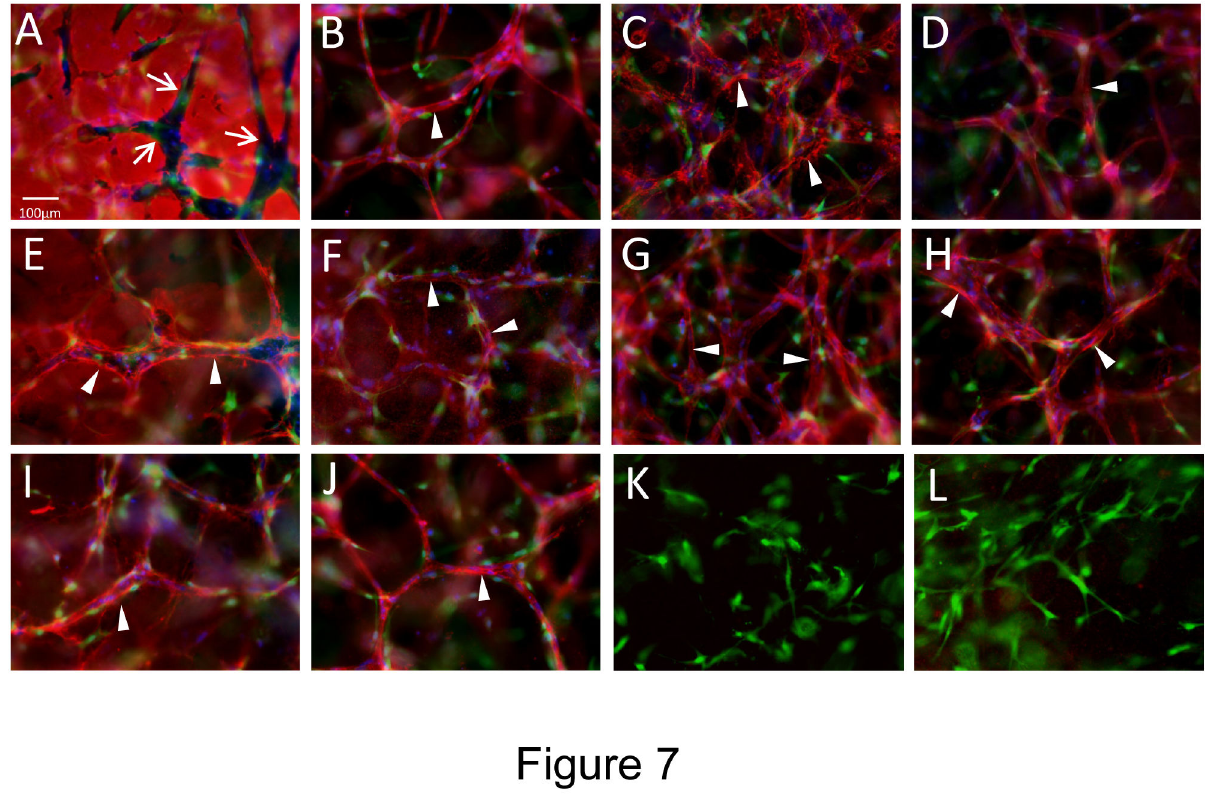
Figure 7. Hematopoietic stem cell cytokines stimulate EC-pericyte tube co-assembly and vascular basement membrane matrix deposition under serum-free defined conditions in 3D fibrin matrices. ECs were primed with VEGF/FGF-2 overnight and then were seeded with GFP-pericytes into 3D fibrin matrices containing SCF, IL-3, SDF-1α, Flt-3L, and FGF-2. After 120 hr, cultures were fixed and stained for extracellular antigens using various antibodies directed to: (A) Fibrin; (B) CD31; (C) Collagen type IV; (D) Laminin; (E) Fibronectin; (F) Perlecan; (G) Nidogen-1; (H) Nidogen-2; (K) Collagen type I; and (L) Collagen type III. In some cultures, the fibrin gel was supplemented with bovine fibronectin (I, J) and a monoclonal antibody that is specific for human fibronectin was used to assess fibronectin deposition within the vascular basement membrane (I). In this case, CD31 antibody staining was shown for comparison (J). In all other cases, the fibrin gels were supplemented with human fibronectin (A-H, K,L). Arrows indicate the borders of vascular guidance tunnels which are generated during EC tubulogenesis and both ECs and pericytes reside within these tunnel spaces (A). Arrowheads indicate vascular basement membrane deposition. Bar equals 25 µm. doi: